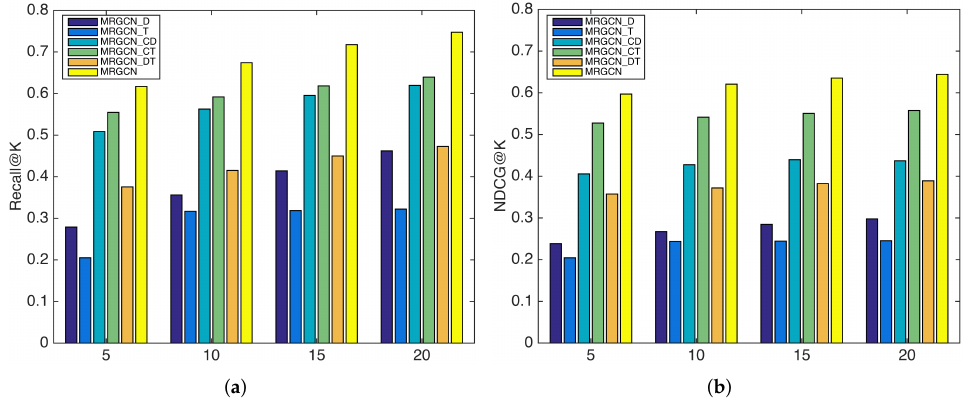
Figure 3. Performance comparison of different variants of MRGCN. ( a ) Recall@K; ( b ) NDCG@K.